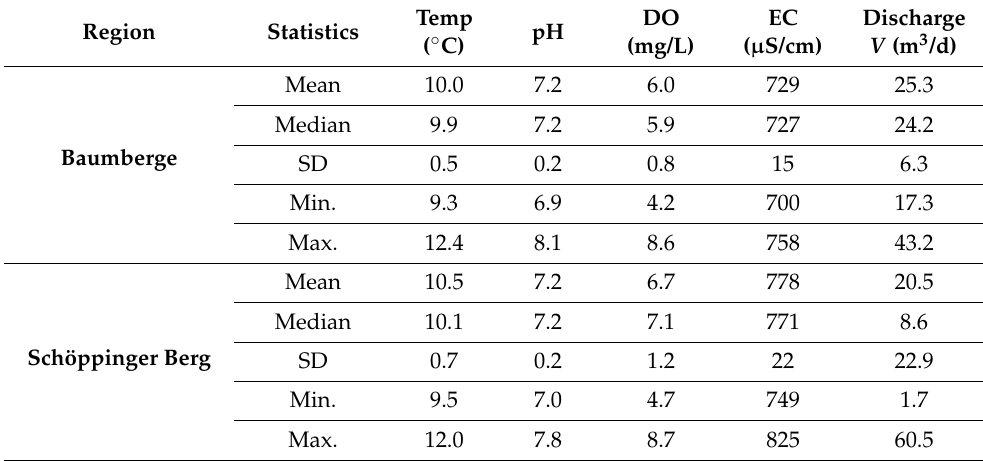
Table 4. Mean, median, SD, and range (minimum = Min., maximum = Max.) of physicochemical parameters measured at springs in Baumberge and Schöppinger Berg in five sampling campaigns